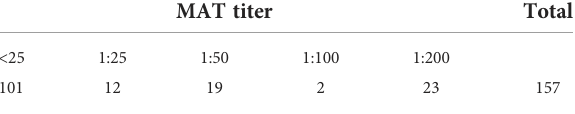
TABLE 2 Antibody titers to T. gondii of the MAT